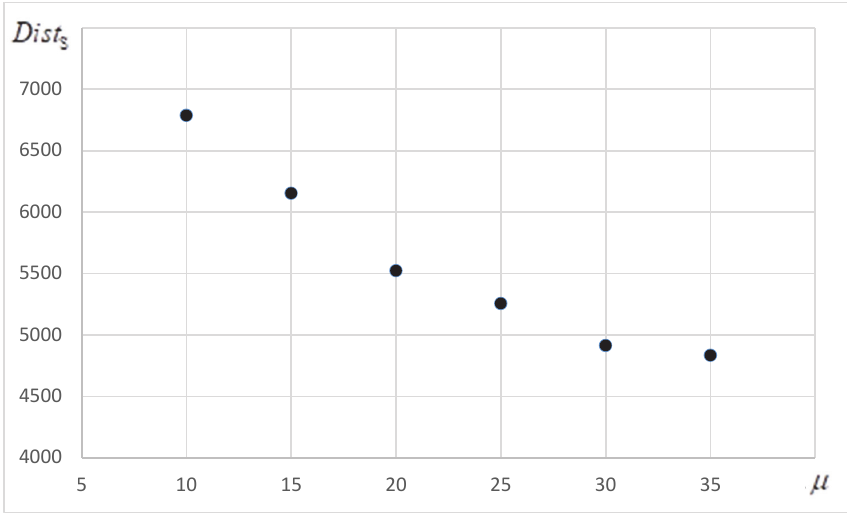
Fig. 4. Dependence of